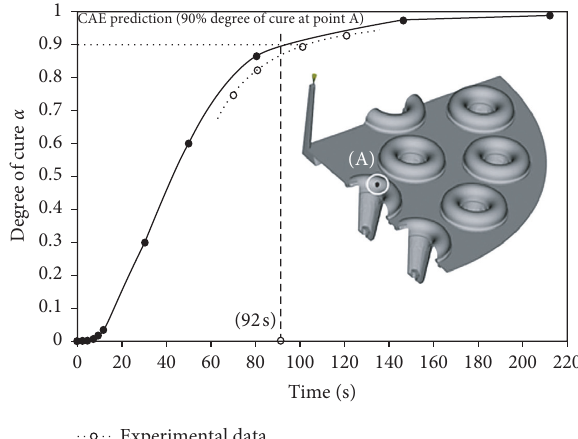
Figure 10: Comparisons of simulated degree of cure α versus time with that obtained from experimental measurements (measure- ments were made only in zones defined as A).